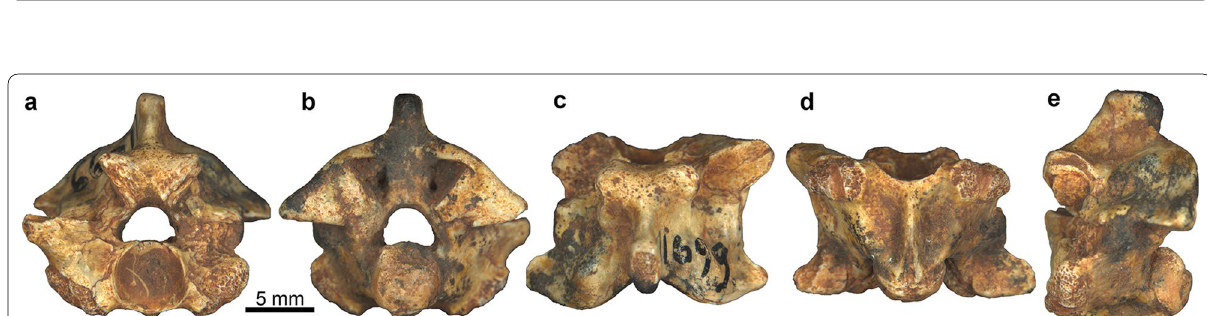
Fig. 11 Palaeopython cadurcensis from an imprecisely known locality in the Phosphorites du Quercy: mid-trunk vertebra (NHMW 2019/0033/0003) in anterior ( a ), posterior ( b ), dorsal ( c ), ventral ( d ), left lateral ( e ), and right lateral ( f ) views